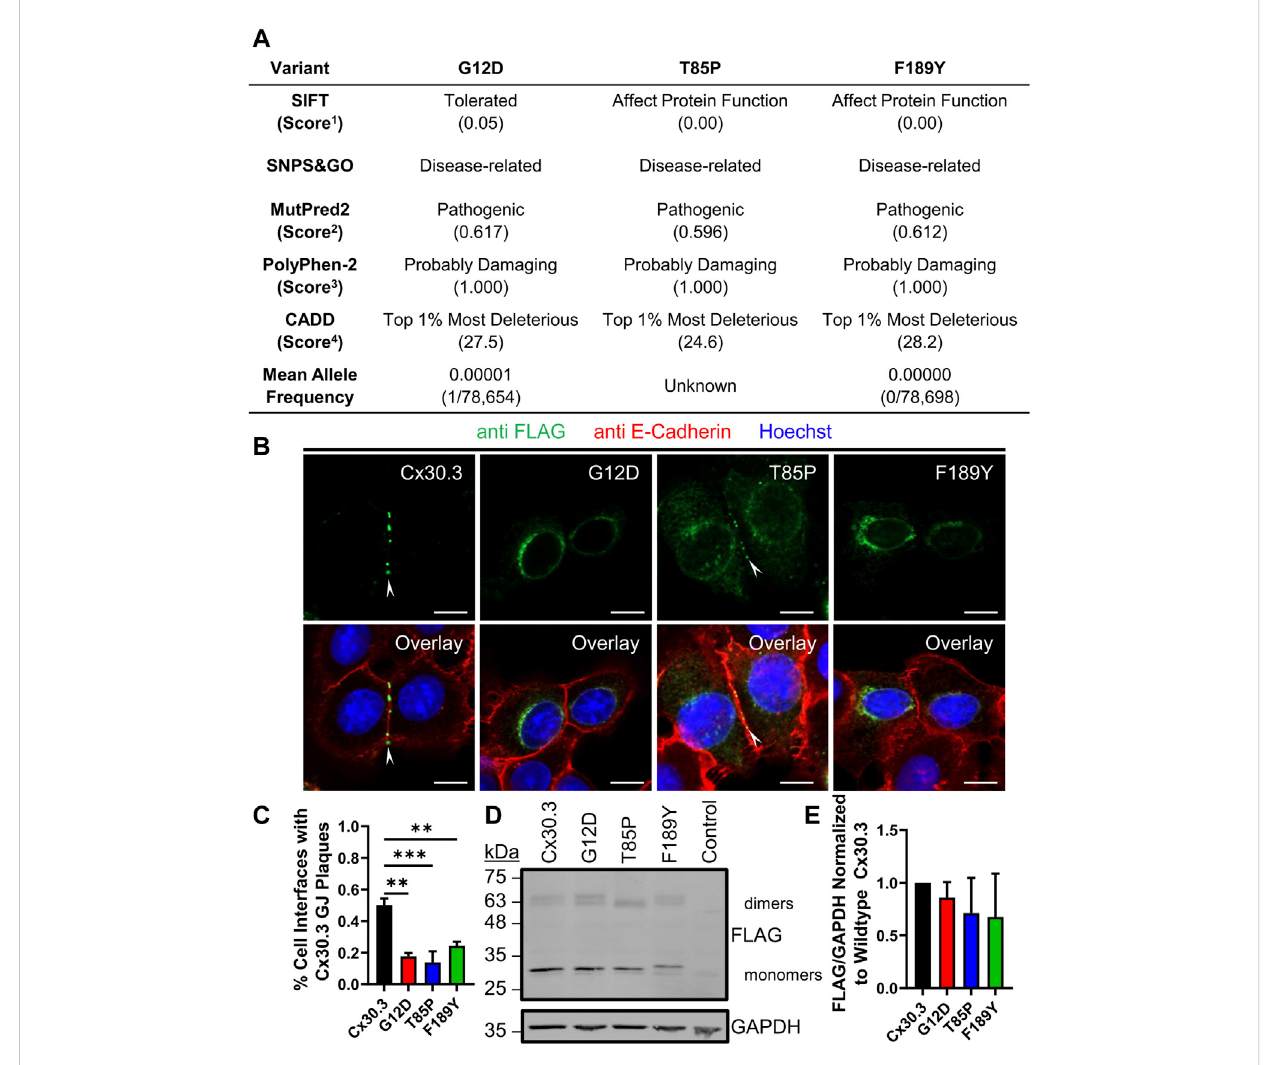
FIGURE 2 EKVP-linked Cx30.3 mutants exhibit impaired gap junction assembly compared to wild type Cx30.3. (A) Summary of in silico predictions of the pathogenicity of theG12D, T85P, and F189Y Cx30.3mutants.Score thresholds are as follows: 1 Score < 0.05 =not tolerated, 2 Score > 0.500 = pathogenic, 3 Score > 0.850 = probably damaging. 4 Score between 20 and 29.9 = top 1% most deleterious substitutions predicted in the human genome. (B) FLAG- tagged Cx30.3mutants(green)exhibitimpairedassembly into gapjunction plaques(arrowheads) atcell-cellinterfaces, as demarcated bytheproxy marker for the plasma membrane, E-cadherin (red). (C) Quanti fi cation reveals that Cx43KO REK pairs expressing Cx30.3 mutants exhibit less gap junctions compared to cells expressing wild type Cx30.3 ( N = 3). (D) Representative immunoblot showing relatively equal expression of FLAG-tagged Cx30.3 mutants. The band corresponding to the F189Y mutant migrated slightly slower than other mutants. (E) Densitometric analysis reveals relatively equal expression of Cx30.3 mutants in Cx43KO REKs ( N = 3). Nuclei are demarcated by Hoechst 33342 staining (blue). Scale bars = 10 μ m ** p < 0.01; *** p <